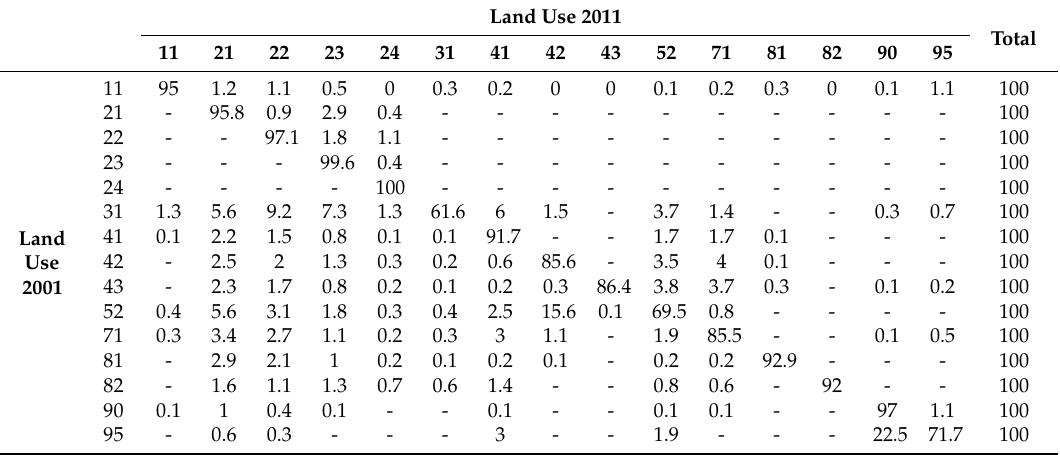
Table 2. Transition matrix showing changes in land use types (%) between 2001 and 2011 in the watershed.